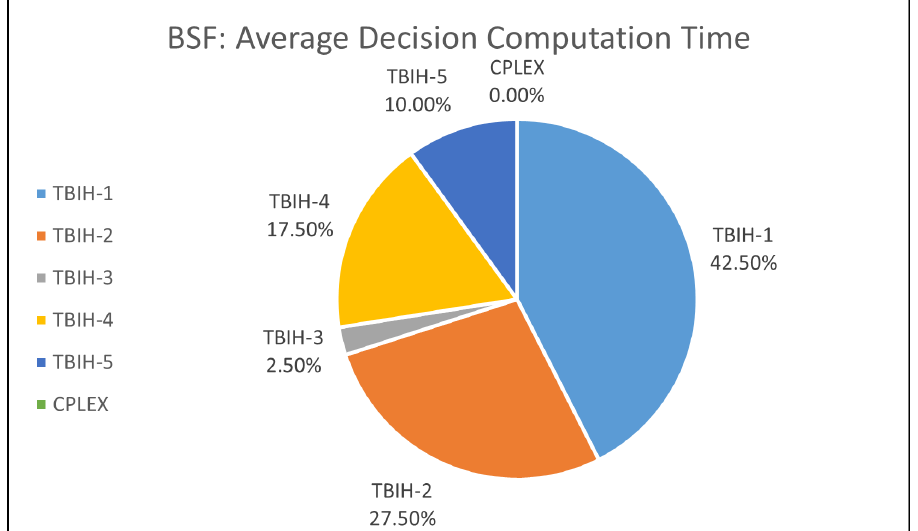
Figure A23. Algorithms performance compared to matheuristic rollout applied in PDS-RA: total BSF measured for average decision computation time over all test instances applied (omitting 10 non-benchmarked